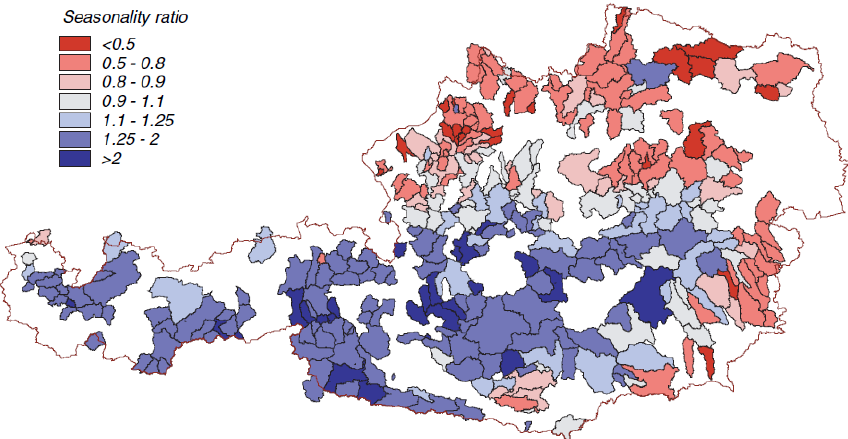
Figure 6. Ratio of summer and winter low-flow discharges (SR) for 325 subcatchments in Austria. SR > 1 indicates a winter low-flow regime, and SR < 1 indicates a summer low-flow regime. From Laaha and Blöschl (2006b).